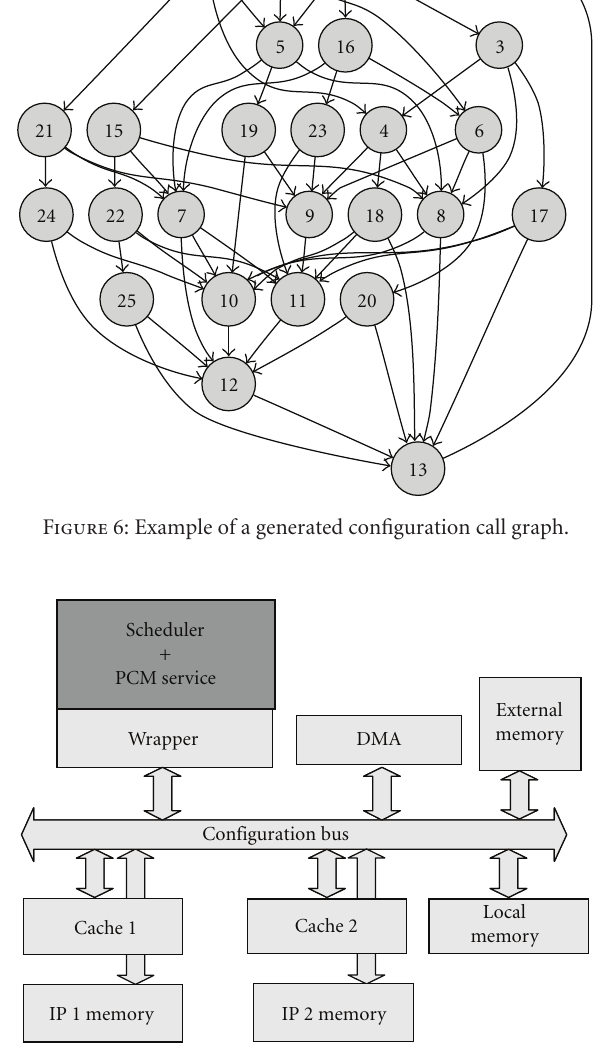
Figure 5: Subgraph example.